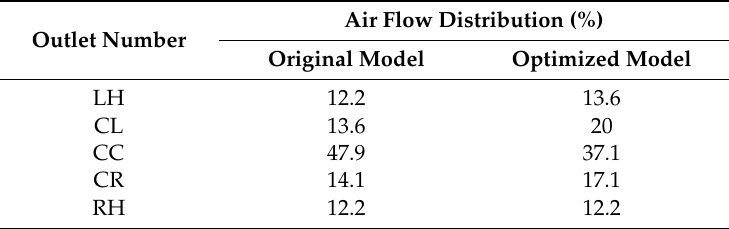
Table 3. Defrosting duct flow distribution calculation results.